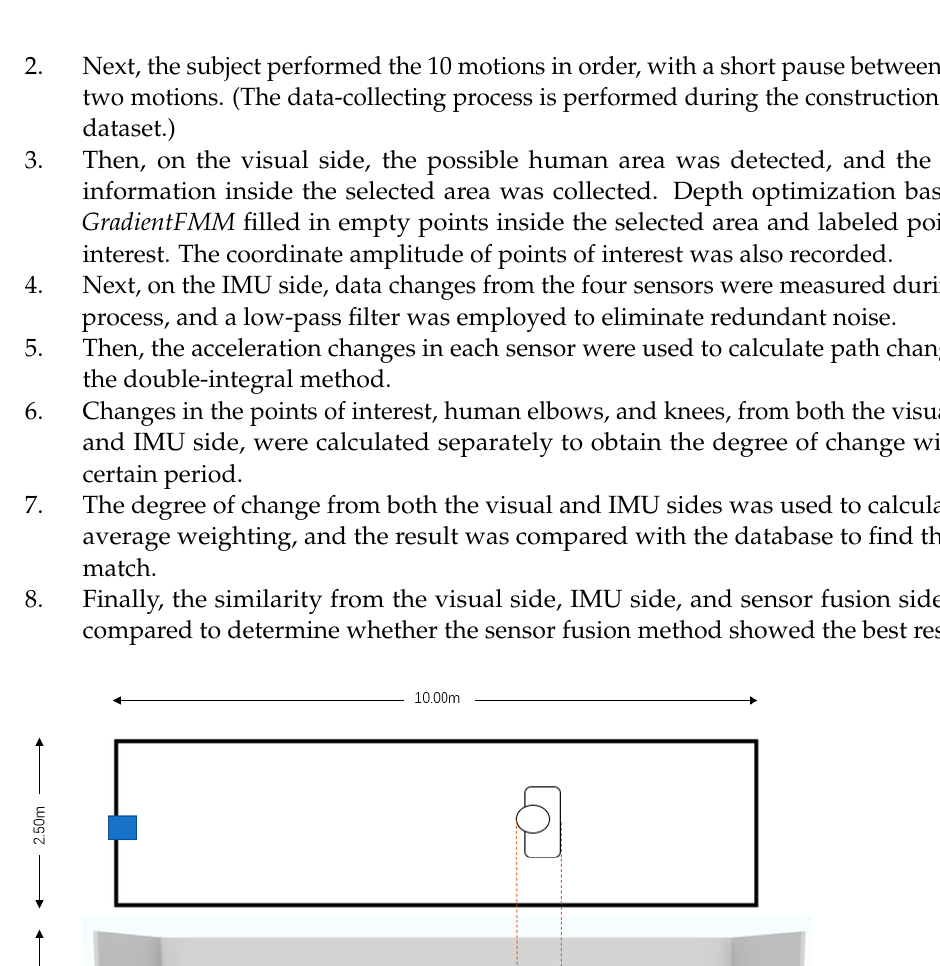
Figure 7. The experiment area layout (top view and 3D front view). Table 1. Description of simulation